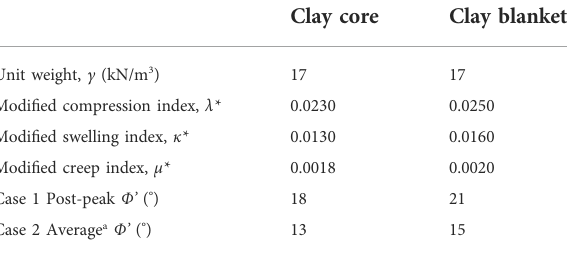
TABLE 4 Numerical modelling parameters.